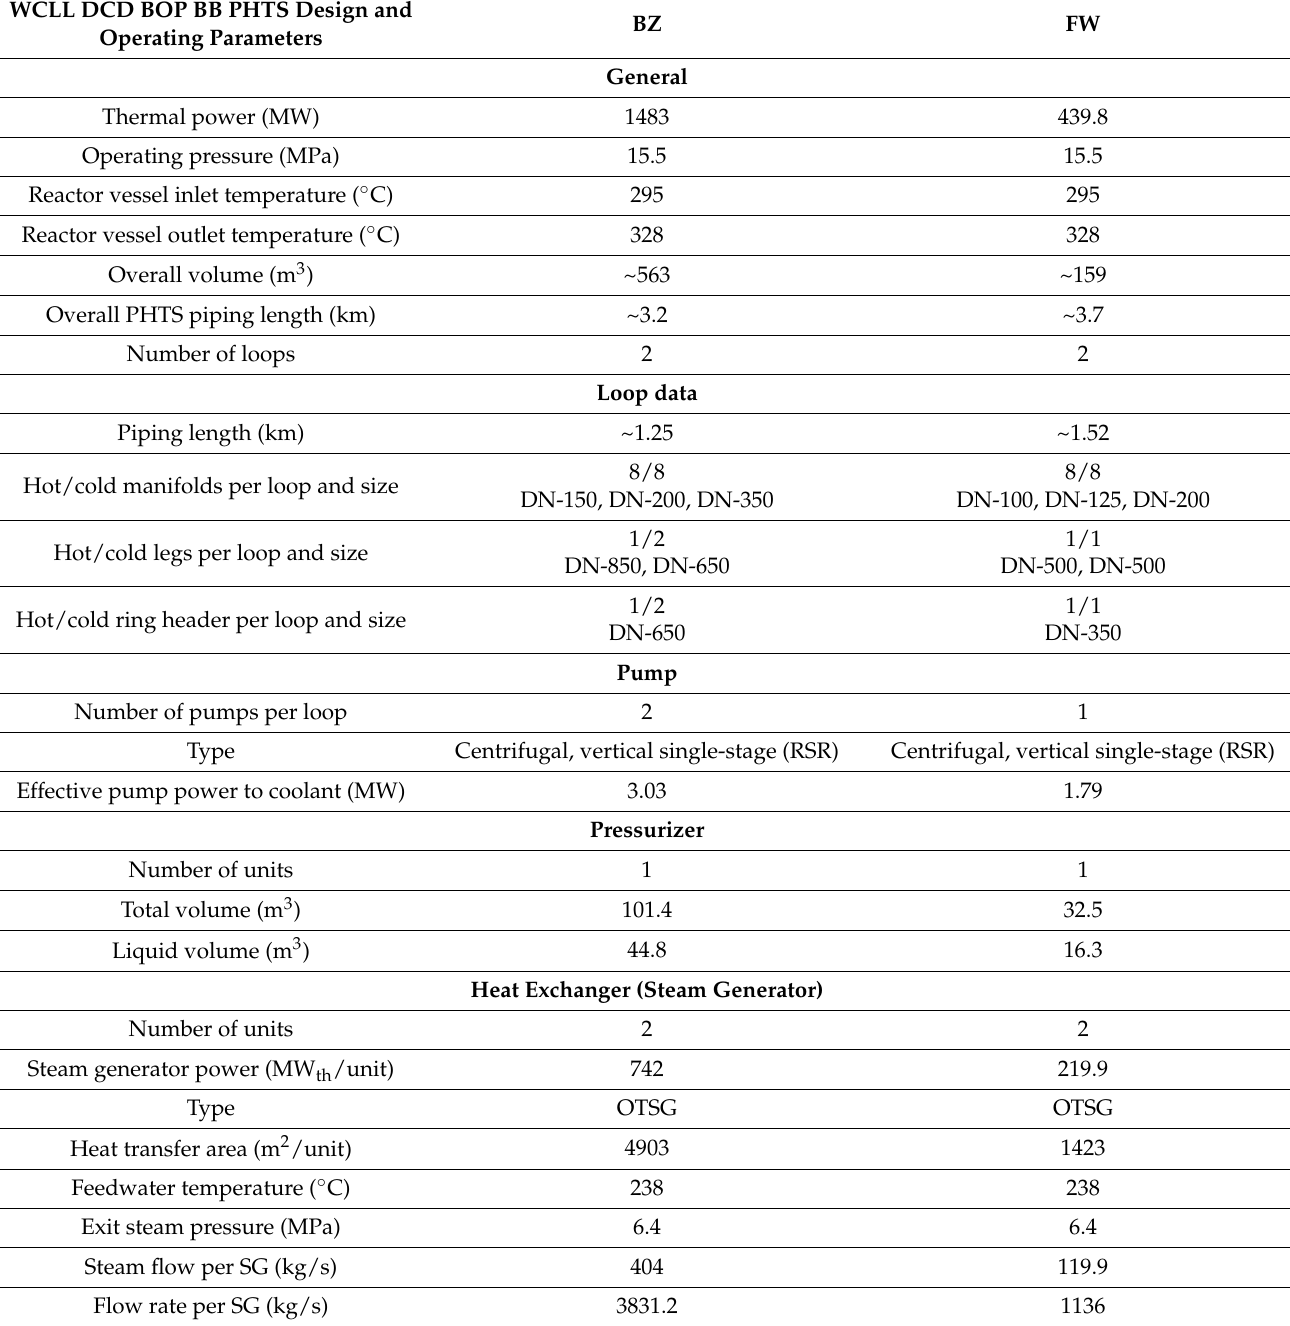
Table 4. System-relevant